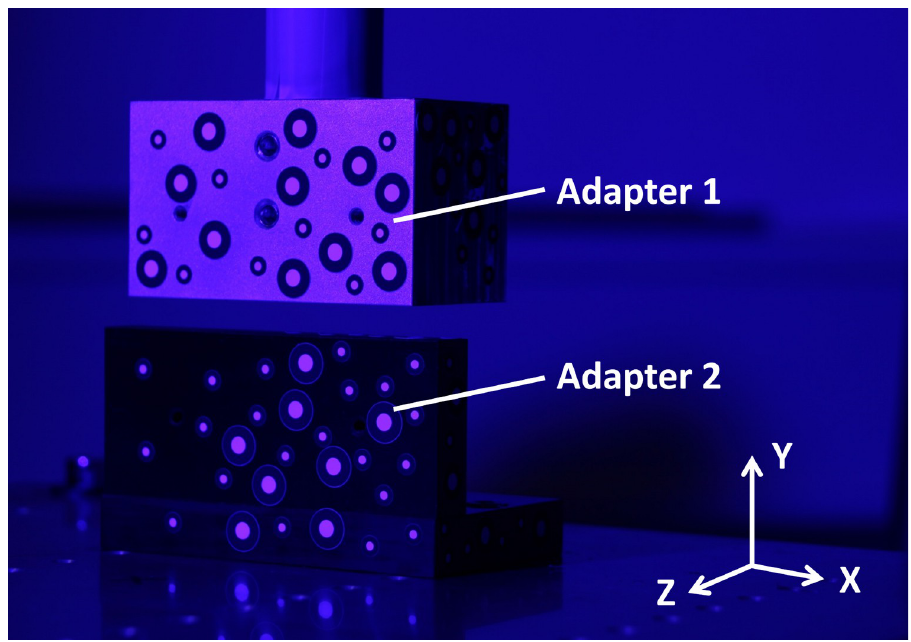
Fig 2. Adapters mounted at the CMM in order to determine the measurement accuracy and zero offset.